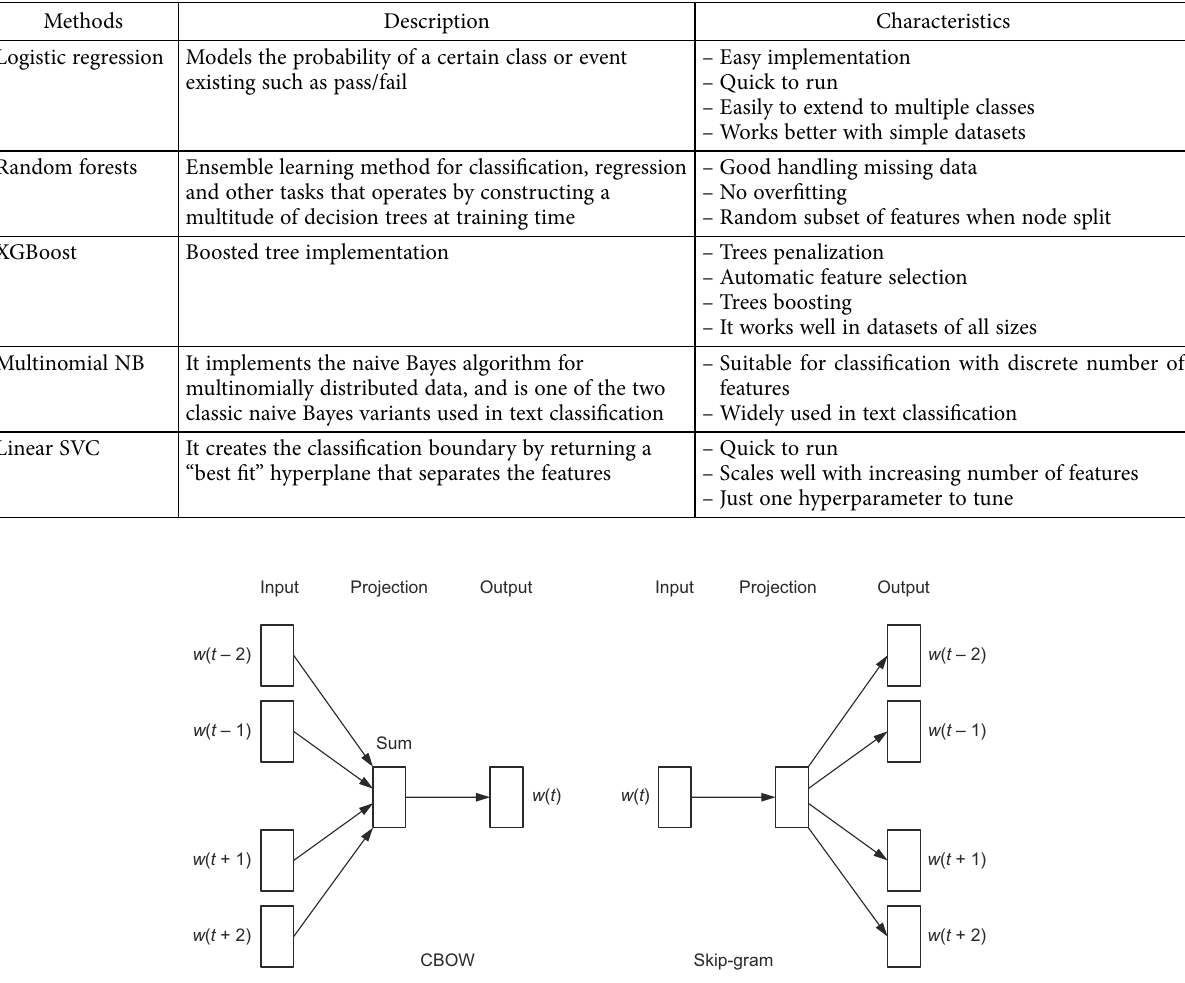
Figure 3. Model representation for vector representation by Mikolov et al.